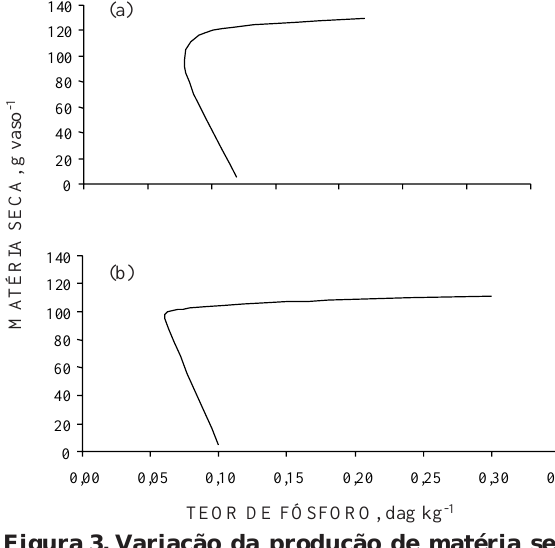
Figura 3. Variação da produção de matéria seca, considerando os teores de fósforo na parte aérea de B. decumbens (a) e de P. maximum (b). Média dos valores aos 42, 56 e 70